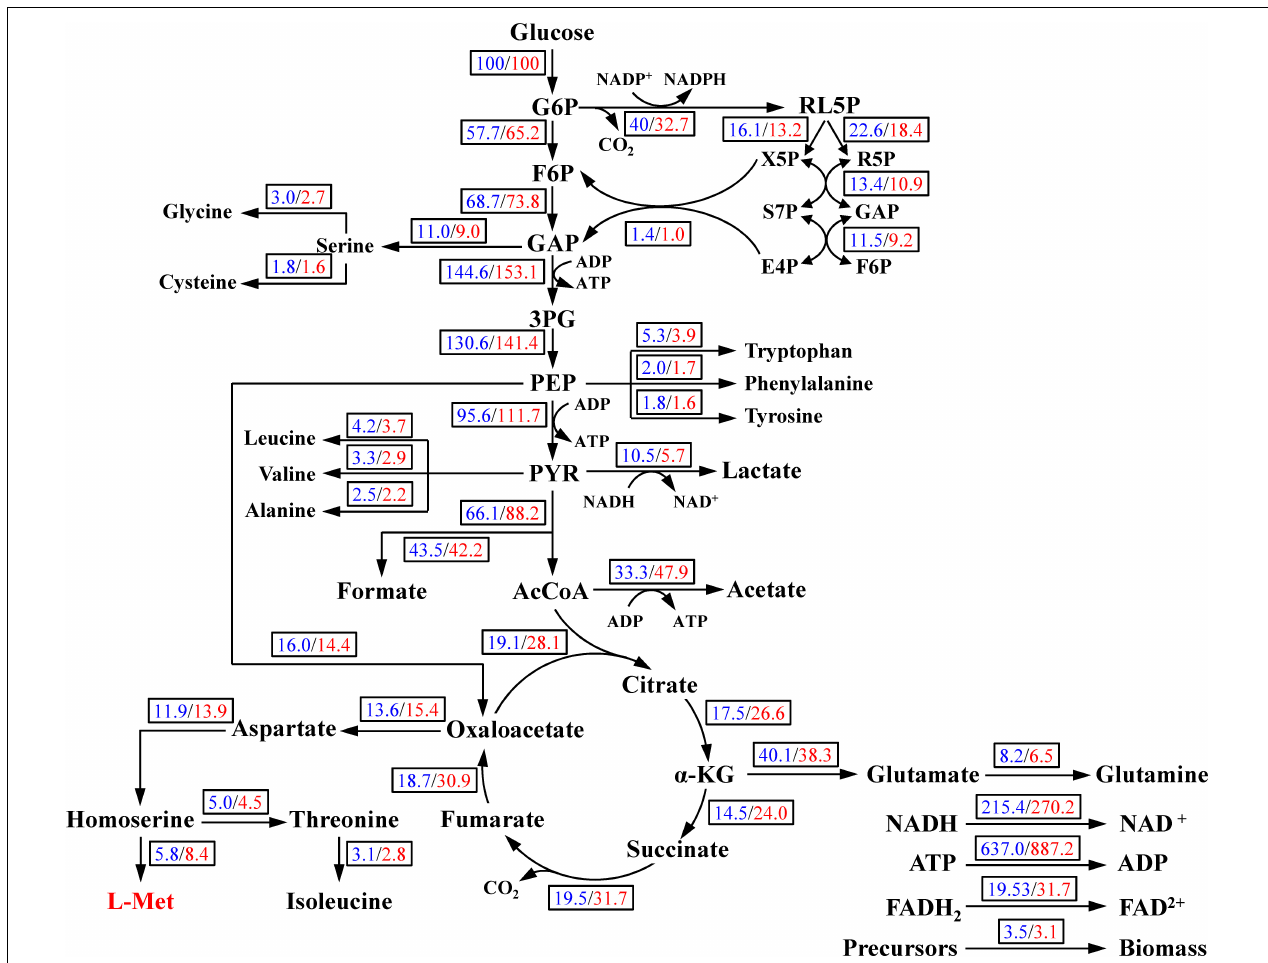
FIGURE 6 | Metabolic flux distributions in the central metabolic pathways at 19 h in the case of control/CaCO 3 addition. Fluxes shown are normalized to glucose uptake rate of 100 for each condition. All data were in mmol/g DCW/h except biomass g/g DCW/h.